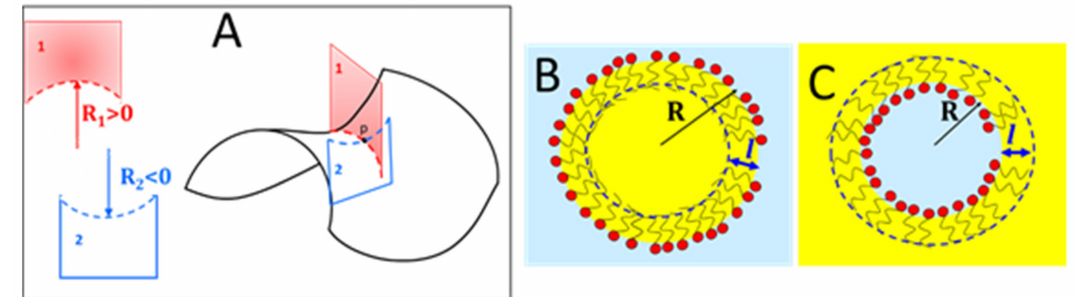
Figure 11. (( A ), right) Intersection of a surface with the orthogonal planes defining the principal curvatures. On the left are shown the corresponding plane curves (dashed) and the principal radii of curvature. ( B , C ) Views of the radius of curvature of the polar / apolar interface ( R ) and of the thickness ( l ) of the interfacial film for spherical o / w and w / o micelles,